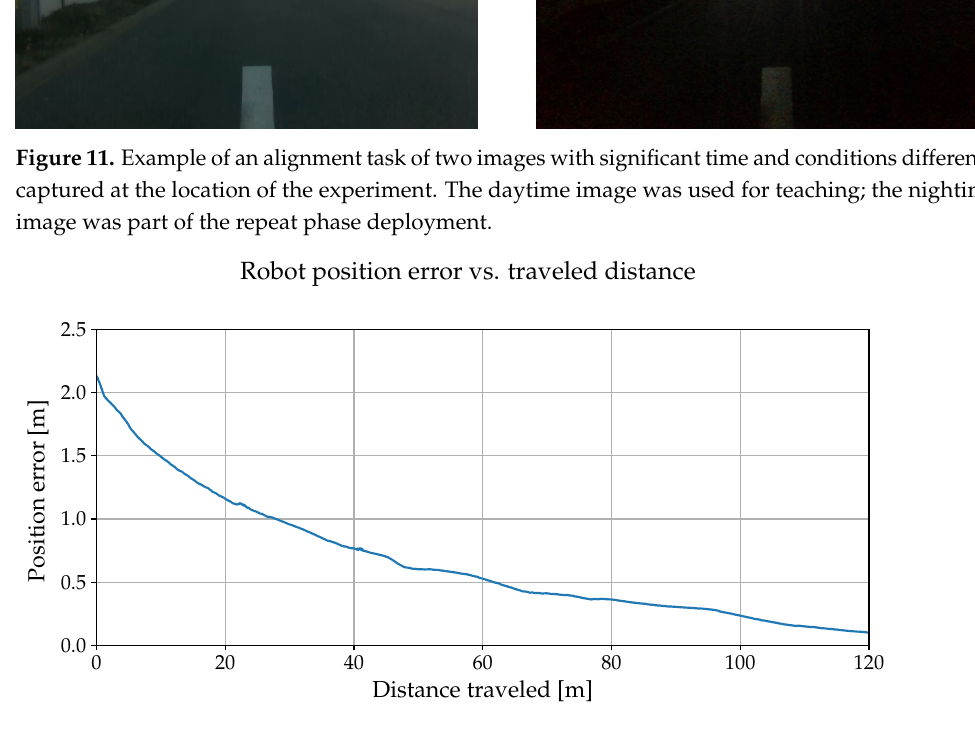
Figure 12. The lateral position error along a 100 m long path and its evolution as our method autonomously steered to correct it.